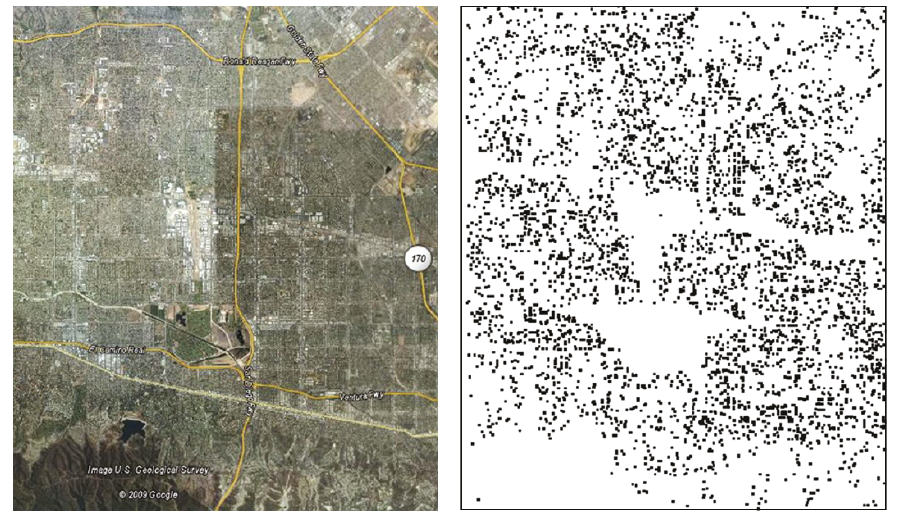
the opposite side. Events on one side of an object, such as a lake or river, should not necessarily predict events on the other